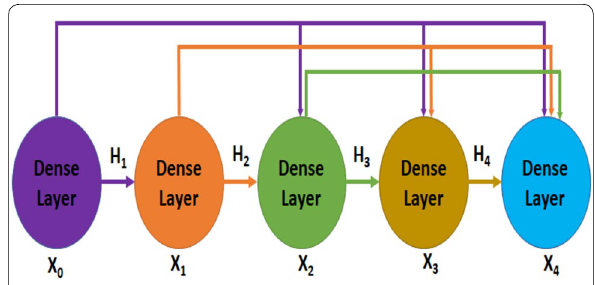
Fig. 3 Illustration of dense connectivity with a 5-layer dense block